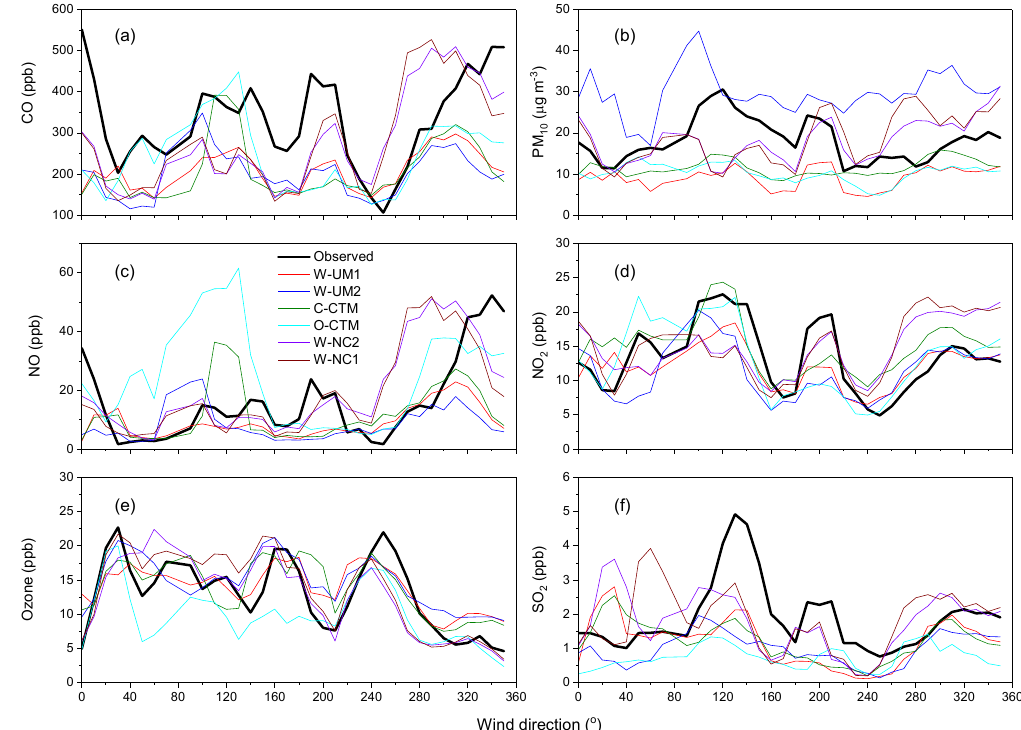
Figure 20. Comparison of observed and simulated angular distributions of ( a ) CO, ( b ) PM 10 , ( c ) NO, ( d ) NO 2 , ( e ) O 3 and ( f ) SO 2 at Westmead during the autumn 2012 SPS-II campaign.